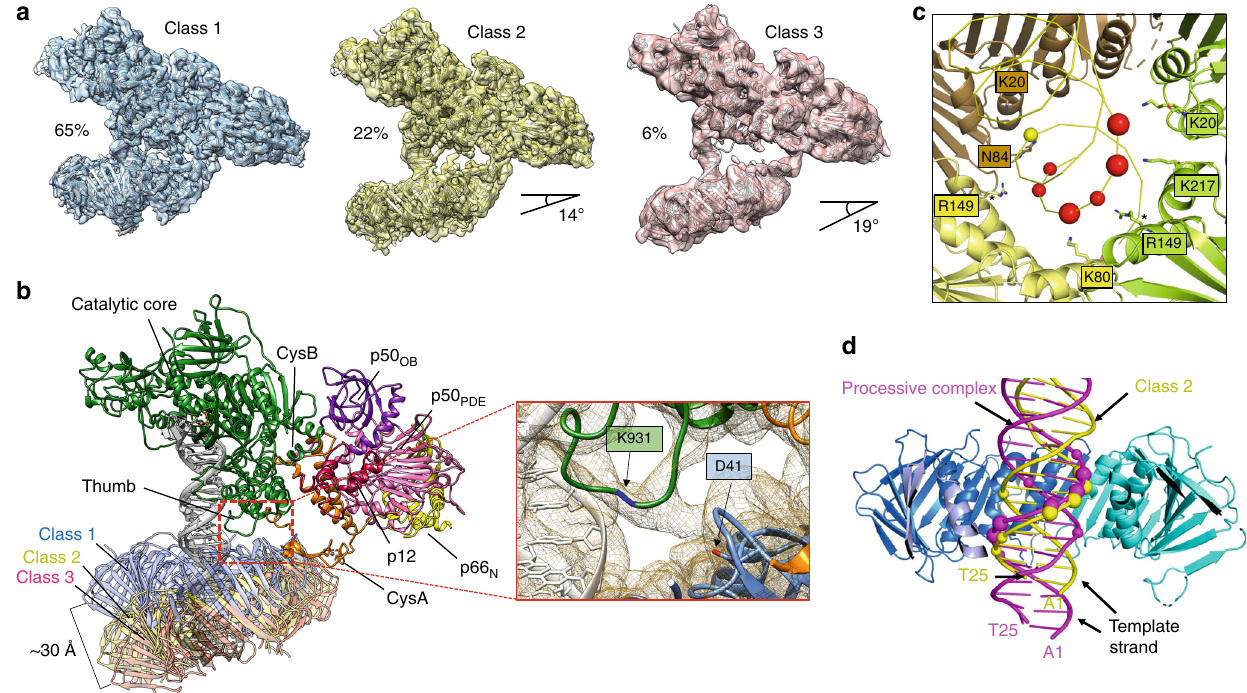
Fig. 4 Alternative conformers of Pol δ holoenzyme. a Three representative EM 3D classes showing increasing tilting of the PCNA ring relative to the polymerase. The percentage values indicated next to the EM reconstructions correlate with the proportion of particles assigned to the three 3D classes and represent an estimate of the prevalence of each conformation in the data set. b Overlay of the models corresponding to the EM reconstructions shown in a . Inset: close up of the EM map of Class 1 showing the contact between the Pol δ thumb domain and PCNA loops. Residues K931 in the Pol δ loop and D41 in the PCNA loop are labelled. Density of K931 side chain is missing, indicating that K931 participates in a fl exible interaction with PCNA. c PCNA interactions with DNA in Class 2. PCNA subunits are shown as cartoons and colored in different shades. DNA is shown as a yellow ribbon. DNA phosphates within a coulombic interaction distance (<6 Å) from PCNA residues are shown as spheres. Interacting phosphates on the template and primer strands are shown in yellow and red, respectively. Phosphates closer than 5 Å are shown with a larger sphere diameter. PCNA interacting residues are shown as sticks and labeled. d Side-view of the processive complex and Class 2 structures aligned using PCNA. The polymerase component is hidden for clarity. PCNA subunits are shown in different shades of blue and the subunit in the foreground is hidden. DNA molecules in the processive and Class 2 complexes are shown as purple and yellow ribbons, respectively. Phosphates interacting with PCNA residues are shown as spheres. Terminal bases of the DNA substrates are